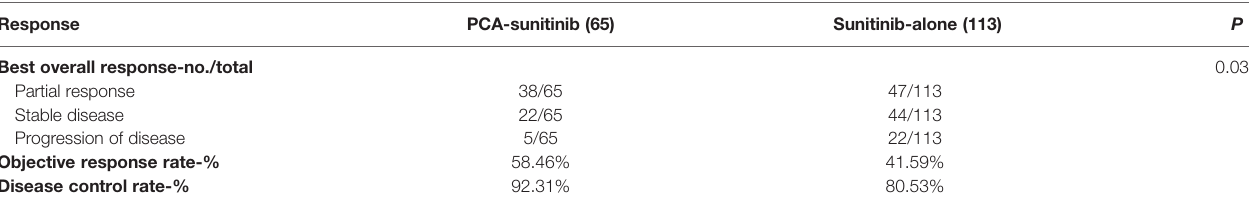
TABLE 2 | Tumor response outcomes.